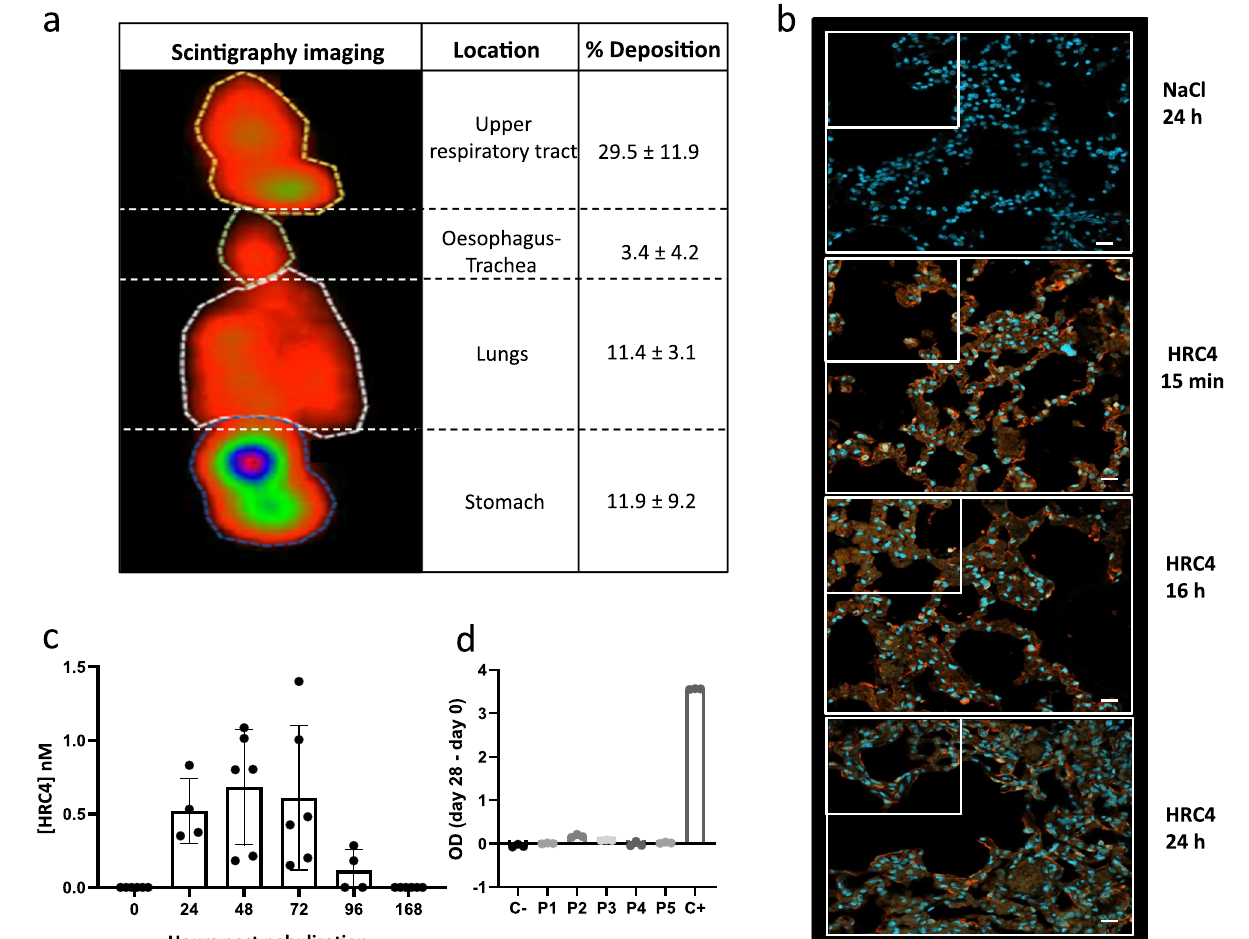
Fig. 3 | Delivery of the aerosol into macaques ’ lungs. a Representative scinti- graphyimagingofdifferentregionsofinterestinacynomolgusmonkeysnebulized with 99m TC-DTPA tracer (74 Mbq) in 3ml NaCl 0.9%, using a prototype mesh nebulizer and measured by E-cam gamma camera. Mean values ±SD of the dis- tribution of aerosol deposition were determined from the digitalized images obtainedinfourexperiments. b Lung localizationoftheaerosolizedHRC4peptide analyzed in cranial lobe lung sections from monkeys nebulized under mechanical ventilation for the indicated time: 15min ( n =1), 24h ( n =2) or 16h ( n =1), prior to euthanasia. Staining was performed with rabbit anti-HRC peptide and goat anti- rabbitAlexa 555 (orange staining) and DAPIwasused to stain nuclei(blue staining)